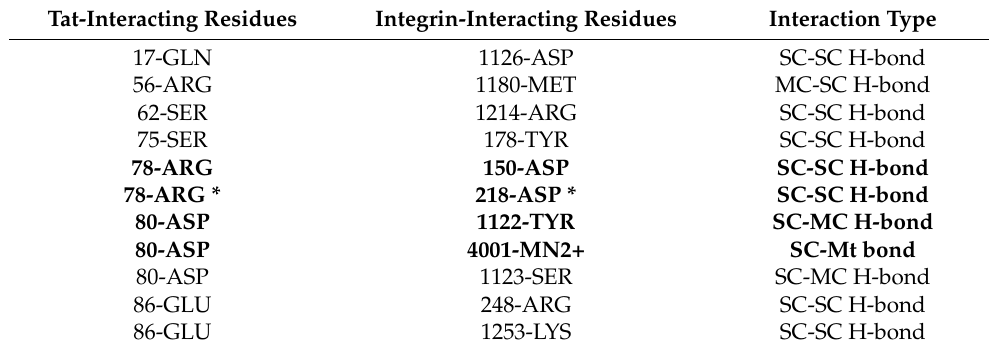
Table 1. Intermolecular H-bonds conserved in at least four of the ten lowest-energy models for the Tat–integrin complex